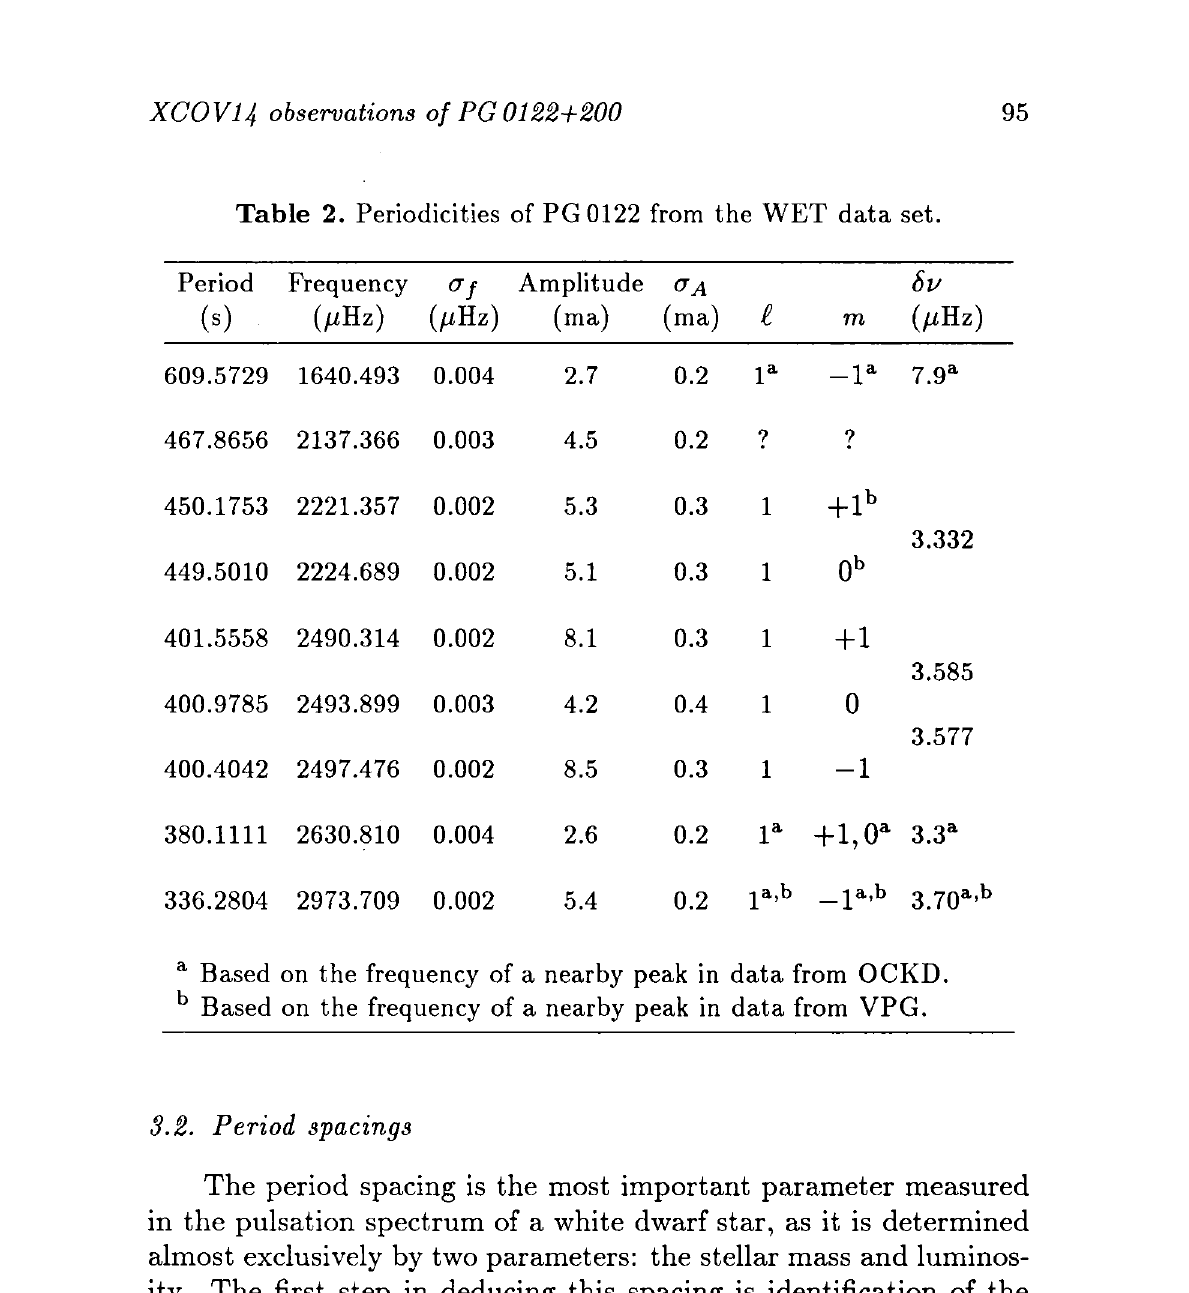
Table 2. Periodicities of PG0122 from the WET data